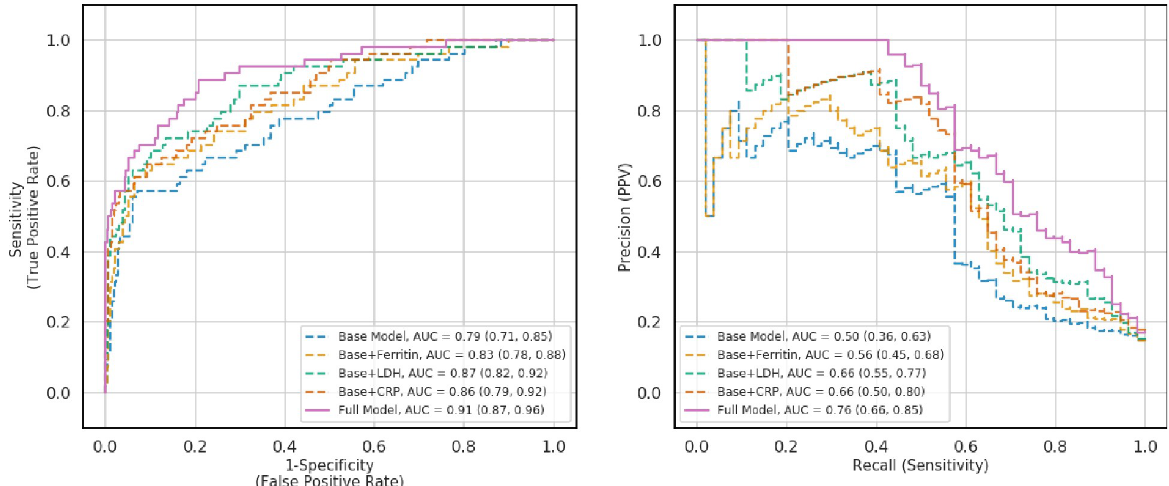
Fig 4. Performance of models while removing one of the features. All analyses were performed on the held-out test set (N = 392). A) Receiver operating curve. B) Precision-recall curve. Base model includes only demographic features and complete blood cell count. Abbreviations: CRP, C- reactive protein; LDH, lactate